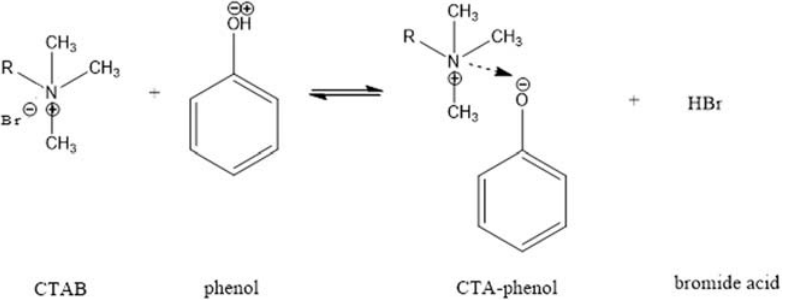
Figure 5: Reaction scheme between CTAB and